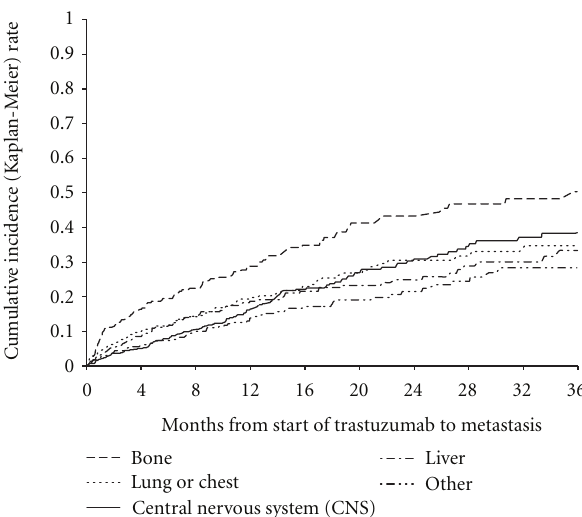
Figure 1: Cumulative incidence of metastases in women with metastatic breast cancer receiving trastuzumab over 36